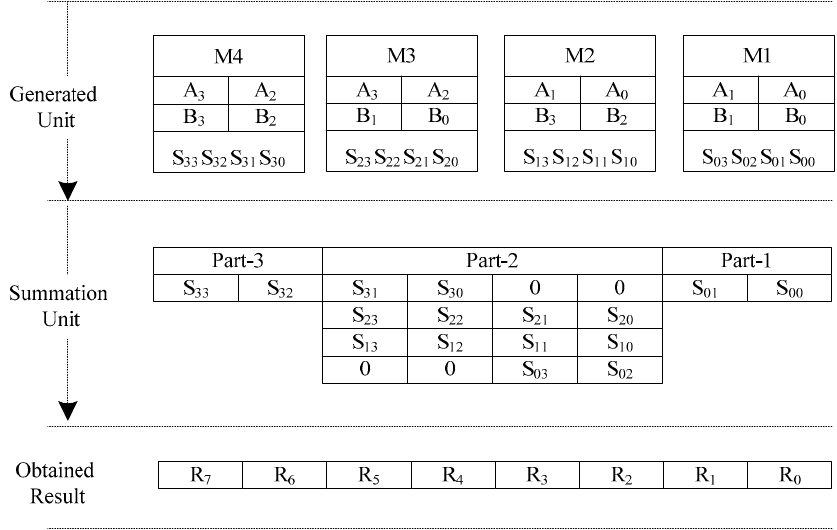
Figure 11. Calculation Process of 4 × 4 Vedic multiplier.